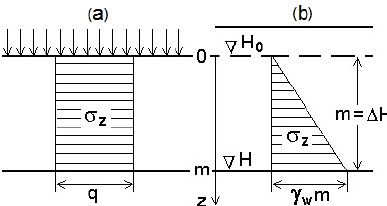
Figure 2. Distribution of additional compressing stresses σz in the soil layer of m thickness under the impact of continuous evenly distributed load q , applied to its surface (a) , and volume forces γ w , arising upon decreasing the groundwater level by (cid:49)H = H 0 − H (b) .